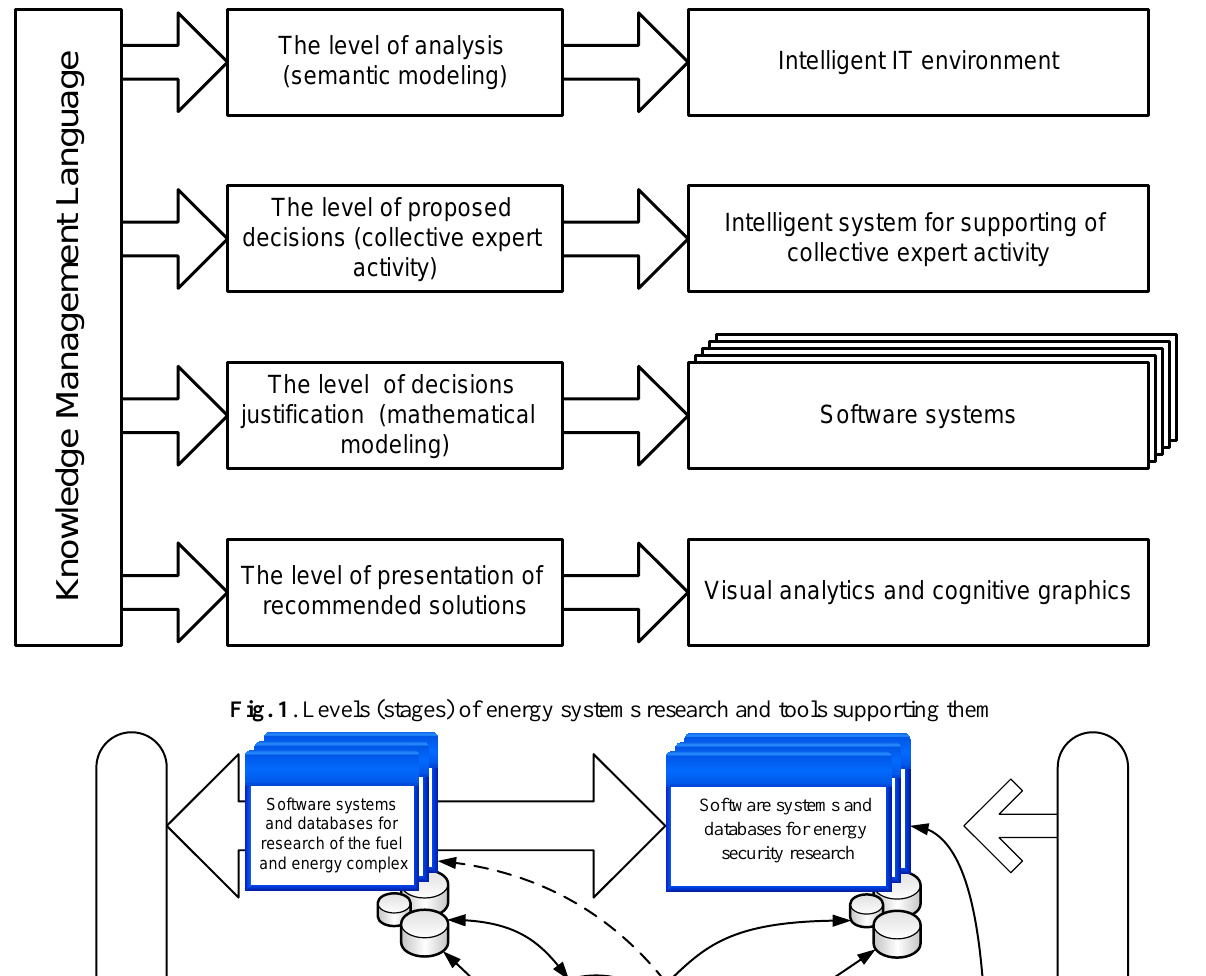
Fig. 1 . Levels (stages) of energy systems research and tools supporting them